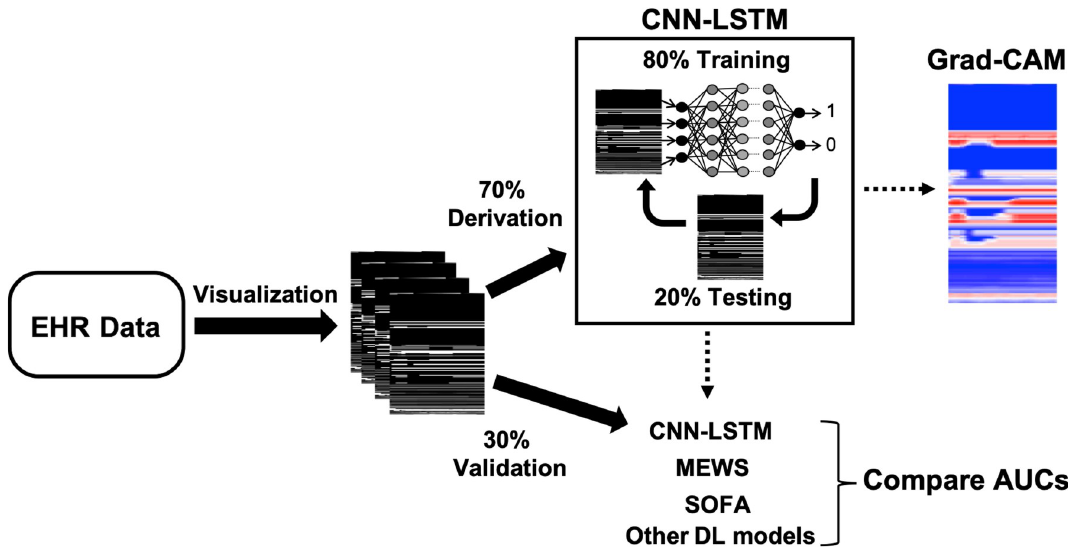
Fig 1. Diagrammatic representation of the